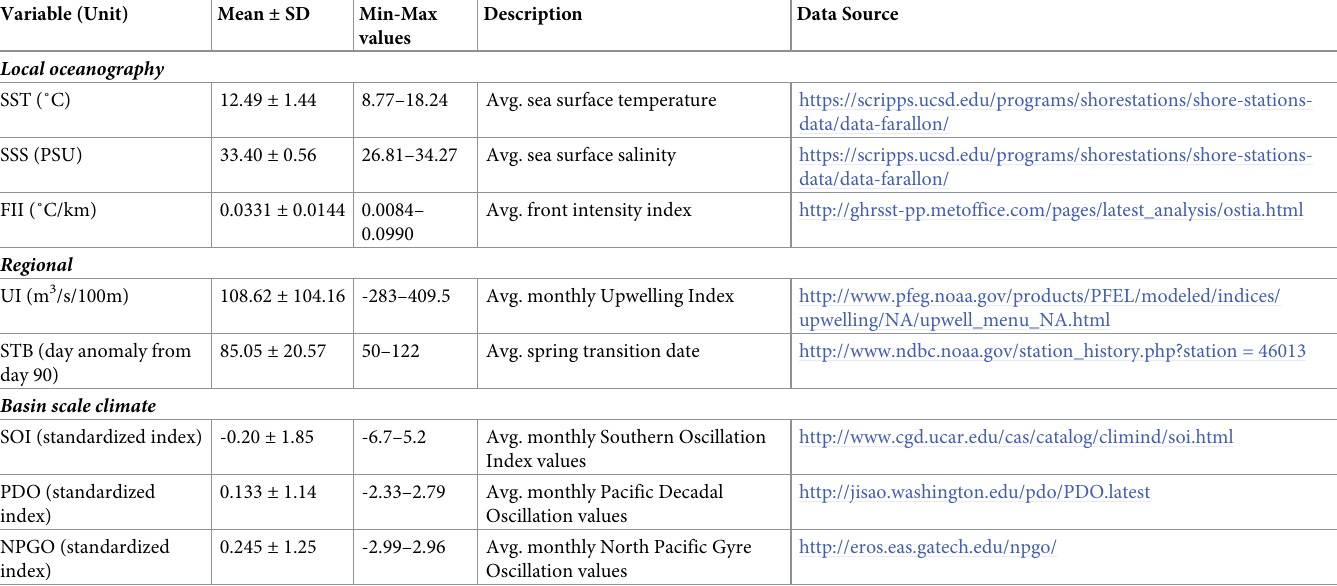
Table 1. Oceanographic and climate data used as environmental